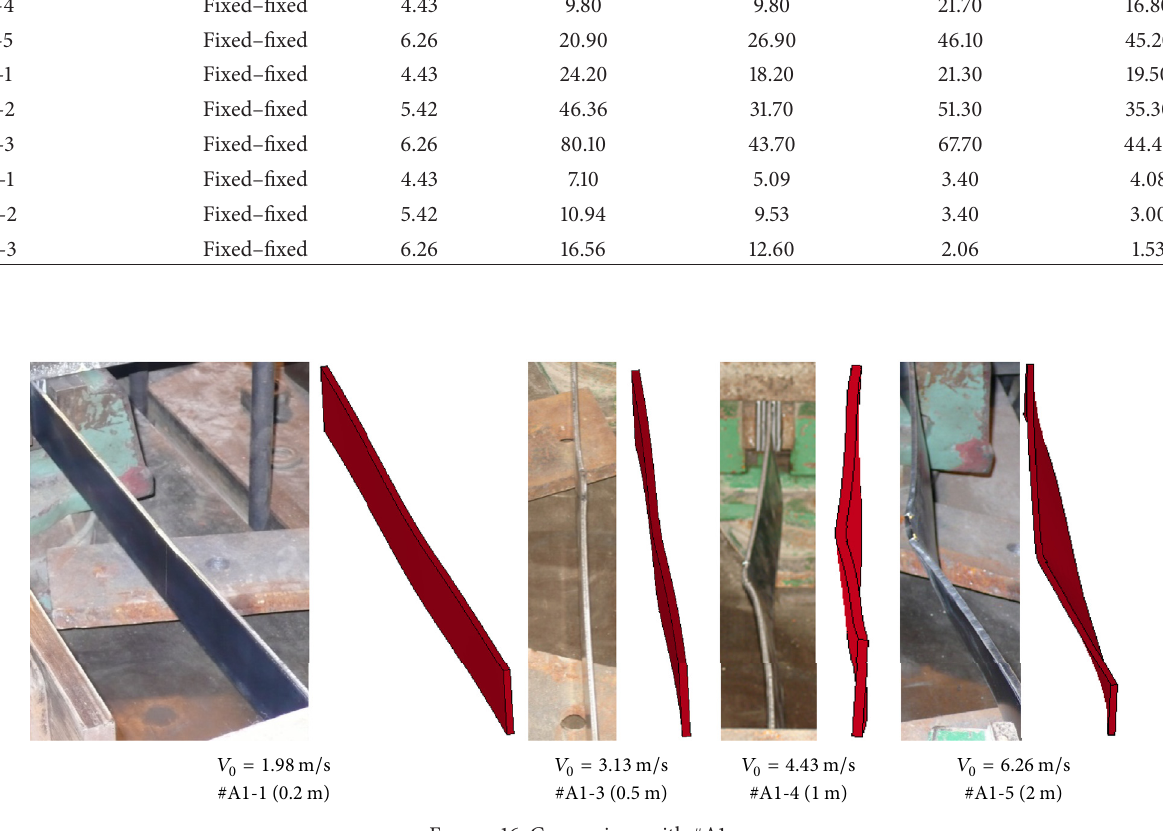
Figure 16: Comparison with #A1.